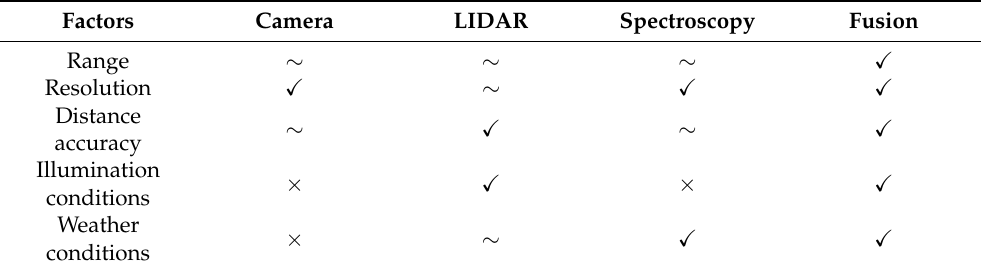
Table 7. Technical characteristics of sensors in autonomous driving and their performances subject to the influences of external factors